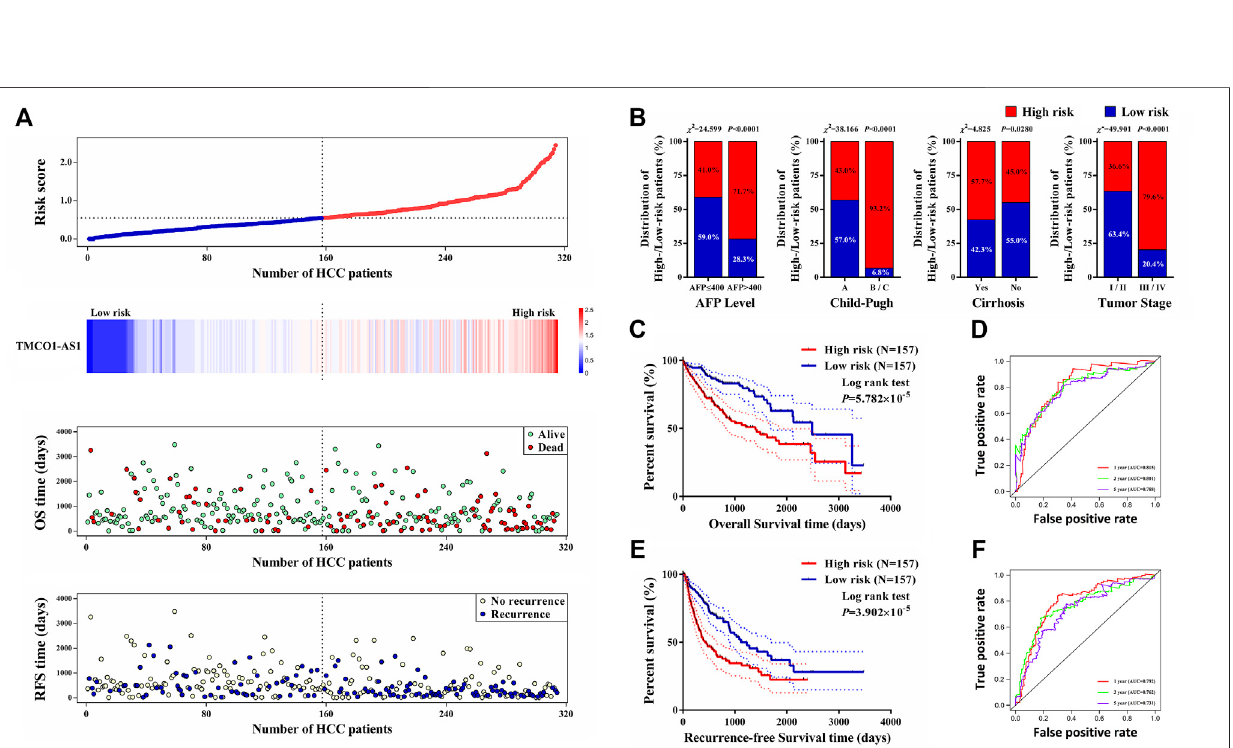
Frontiers in Molecular Biosciences |